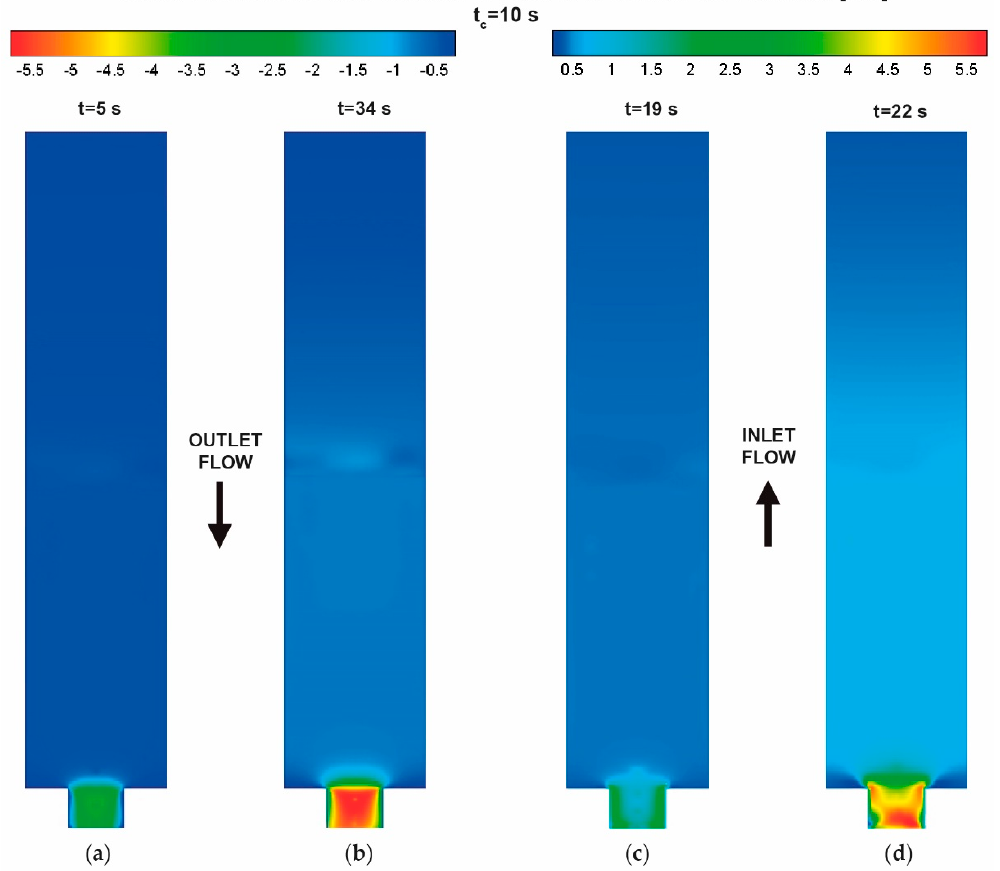
Figure 10. Water inlet and outlet velocity in the closed surge tank considering a guide vanes closing scheme with a t c =10 s. ( a ) t =5 s; ( b ) t =34 s; ( c ) t =19 s; and, ( d ) t =22 s.